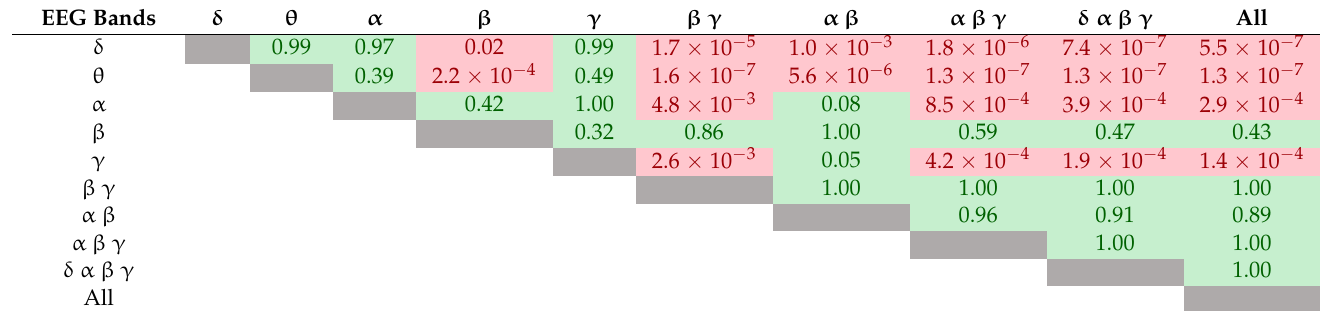
Table 7. p -values F (9, 280) obtained using pair-wise Tukey’s honestly significant difference procedure between different frequency bands. The results for the second scenario when training and testing feature set vectors were separated by recording sessions. The red indicate a statistical difference in accuracy, the green, that there is no enough evidence for